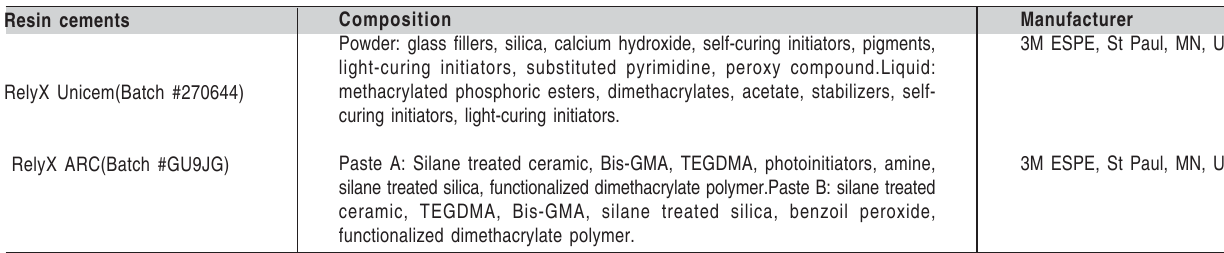
Table 1. Materials used in the study with composition and manufacturer’s Composition Resin cements Powder: glass fillers, silica, calcium hydroxide, self-curing initiators, pigments, light-curing initiators, substituted pyrimidine, peroxy compound.Liquid: methacrylated phosphoric esters, dimethacrylates, acetate, stabilizers, self- RelyX Unicem(Batch #270644) curing initiators, light-curing initiators. Paste A: Silane treated ceramic, Bis-GMA, TEGDMA, photoinitiators, amine, RelyX ARC(Batch #GU9JG) silane treated silica, functionalized dimethacrylate polymer.Paste B: silane treated ceramic, TEGDMA, Bis-GMA, silane treated silica, benzoil peroxide, functionalized dimethacrylate polymer.